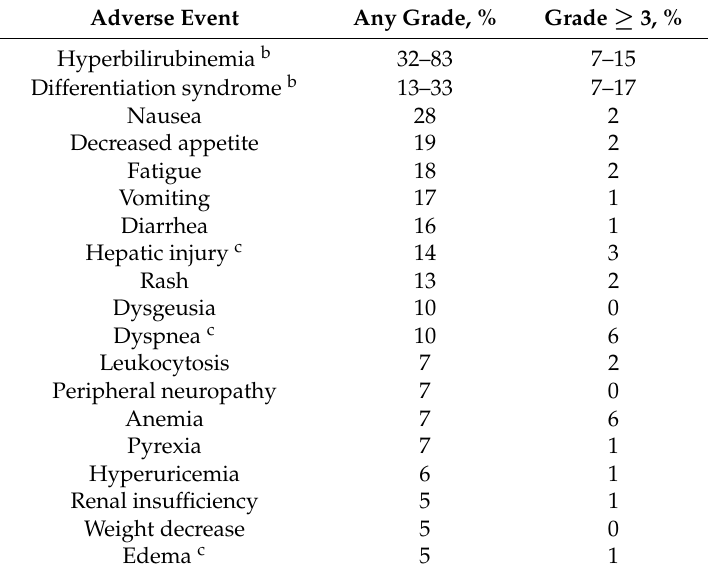
Table 2. Enasidenib-related treatment-emergent adverse events a [85]. Adverse Event Any Grade, % Grade ≥ 3, % Hyperbilirubinemia b